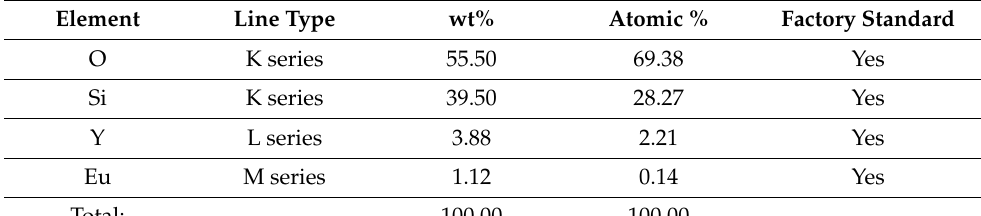
Table 2. The atomic percent of 6% Eu-doped Y 2 O 3 -coated diatomite.